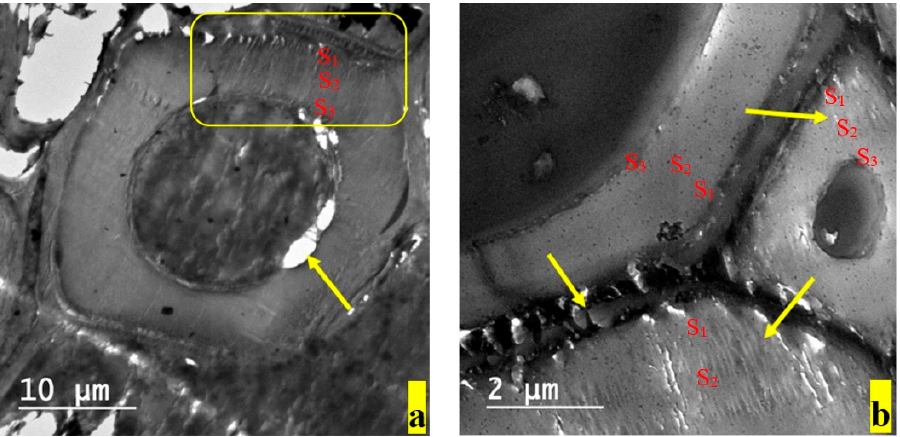
Figure 5. TEM photos of wood samples infected with A. tenuissima, showing cavities within the S 3 layer similar to soft-rot decay type I ( a ). Furthermore, checks and fissures (shown by arrows), are found within the S 1 and S 2 layers, with extensive erosion of the middle lamellae region ( b